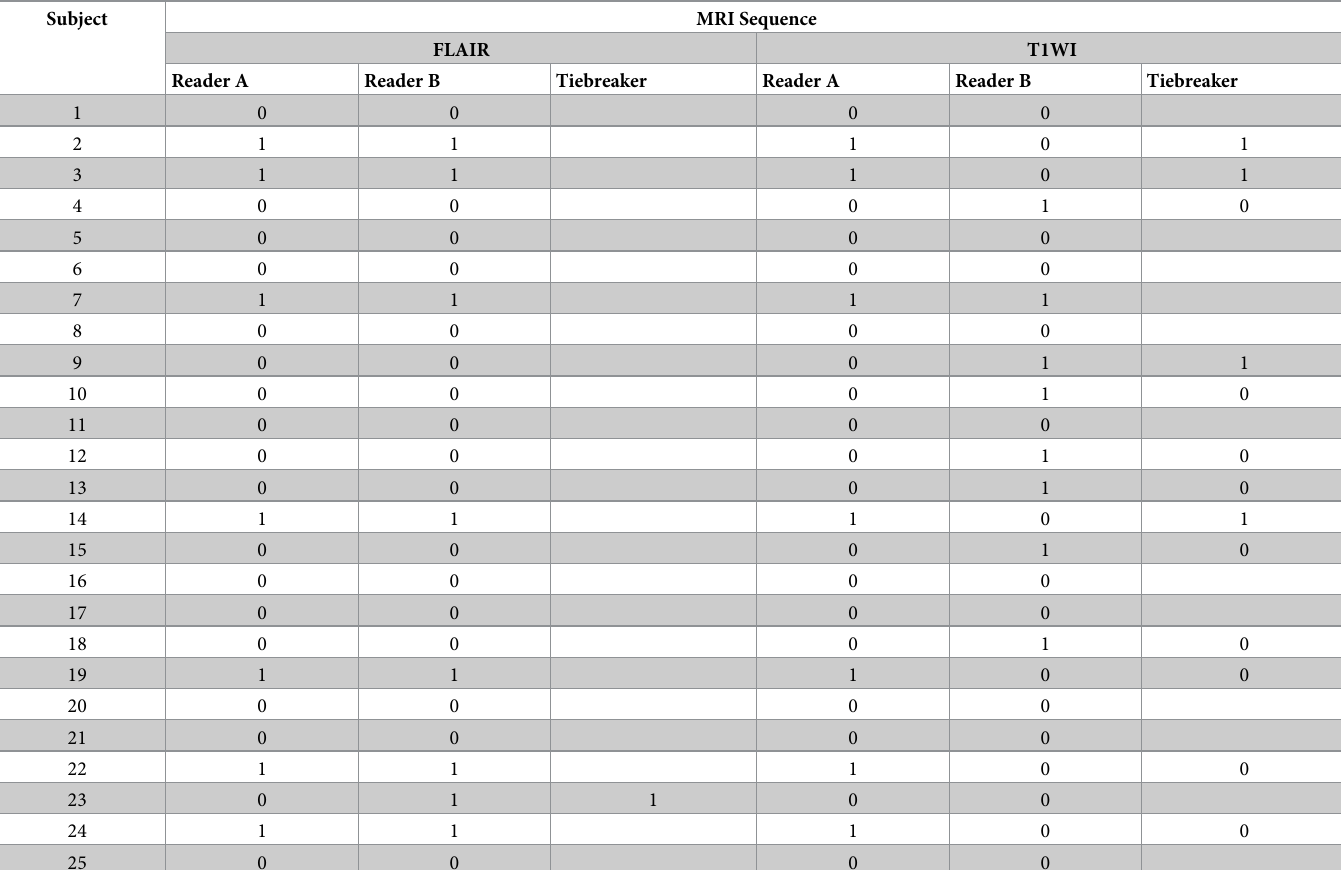
Table 2. Breakdown of blinded scoring for presence of traumatic meningeal